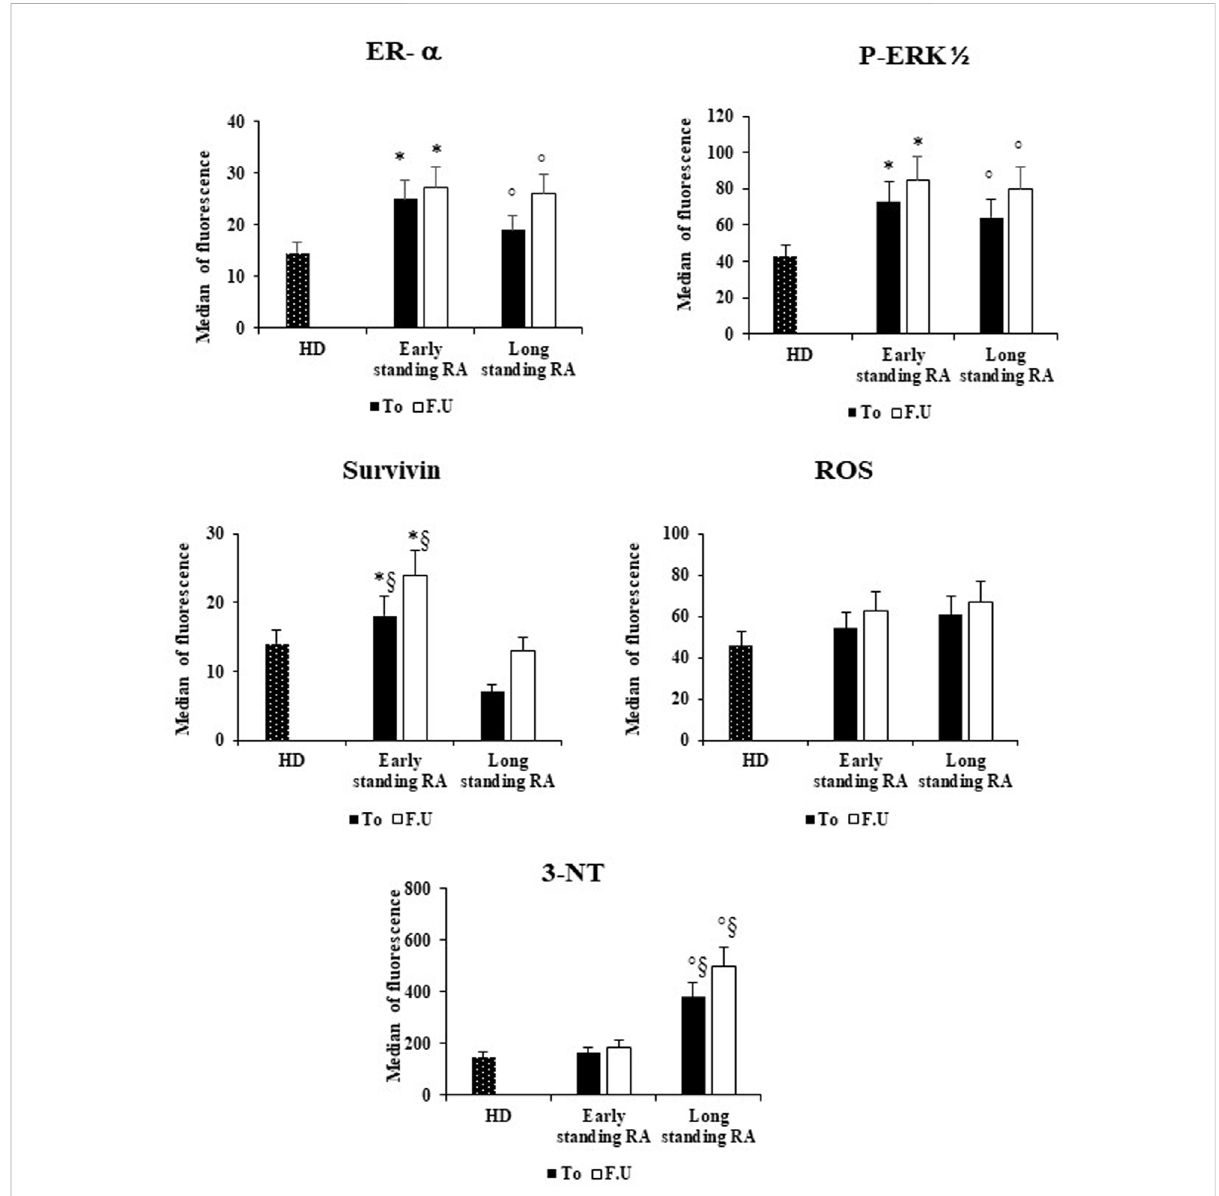
FIGURE 3 EffectsofDMARS therapyon theER- α expression andontheamountsofin fl ammatoryandoxidative stressinRBCsofearly-andlong-standing RApatients.RBCsfromhealthydonors(HD),early-andlong-standingRApatientswereanalyzedby fl owcytometryanalysisfortheexpressionofER- α , p-ERK 1/2 , and survivin, and for the content of ROS and 3-NT, before (T 0 ) and after 6 months of DMARDs treatment (F.U.). * RA (T 0 and F.U.) vs . HD. ° p < 0.05 long-standing RA (T 0 and F.U.) vs . HD. § p < 0.05 early-vs . long-standing RA (T 0 and